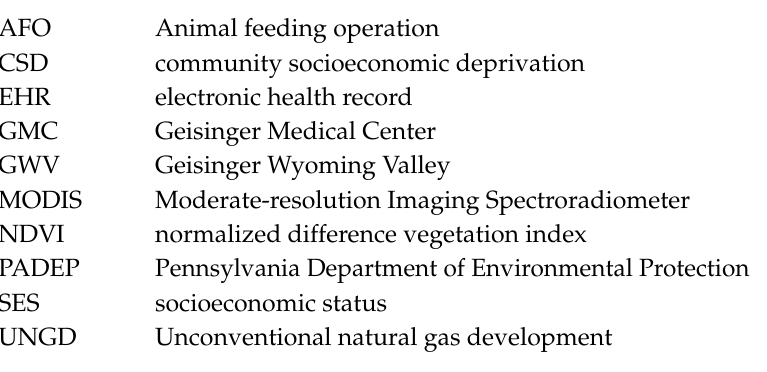
Table S1: Unadjusted and adjusted associations of tertiles 2–3 versus tertile 1 of residential greenness exposure and pregnancy outcomes in original population, Table S2: Unadjusted and adjusted associations of continuous residential greenness exposure and pregnancy outcomes in original and restricted populations, Figure S1: Conceptual framework with relations among residential greenness, confounders, mediators and birth outcomes, Figure S2: Propensity score distributions for patients in ( A ) boroughs; ( B ) townships; and ( C ) cities comparing those with NDVI values in the 2nd and 3rd